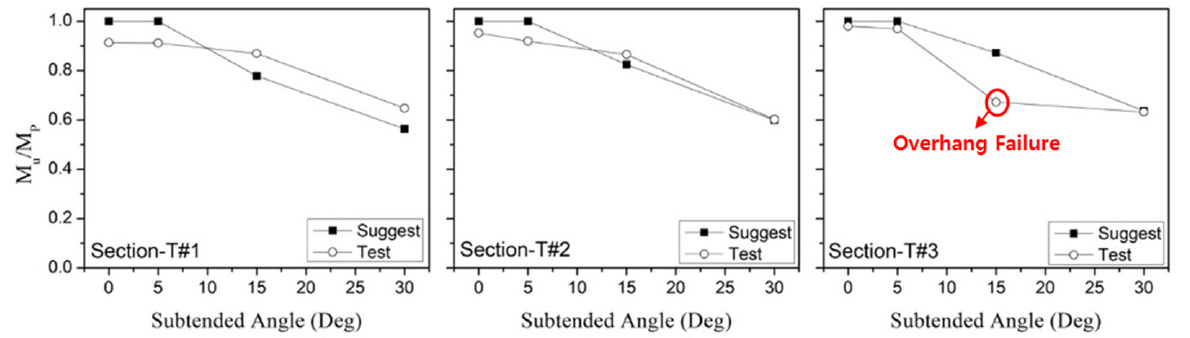
Figure 17. Ultimate Strength Comparison per Subtended Angle.